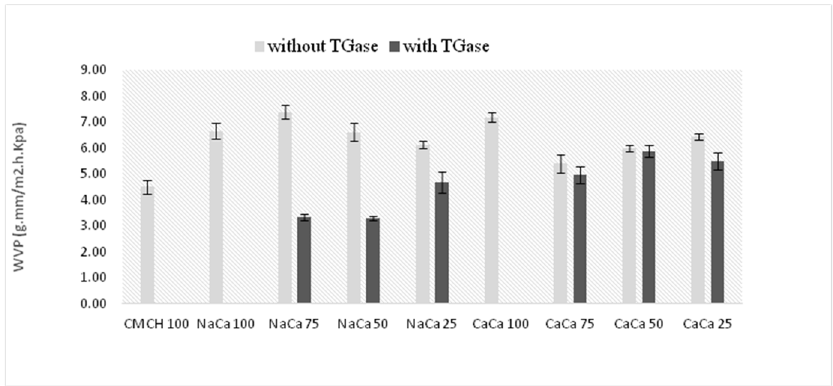
Figure 5. Water vapor permeability of CA-CMCH composite films [CHCH = carboxymethyl chitosan; NaCA = sodium caseinate, CaCA = calcium caseinate, 100, 75, 50, and 25 represent the proportion of the individual component, the balance out of 100 being CMCH].